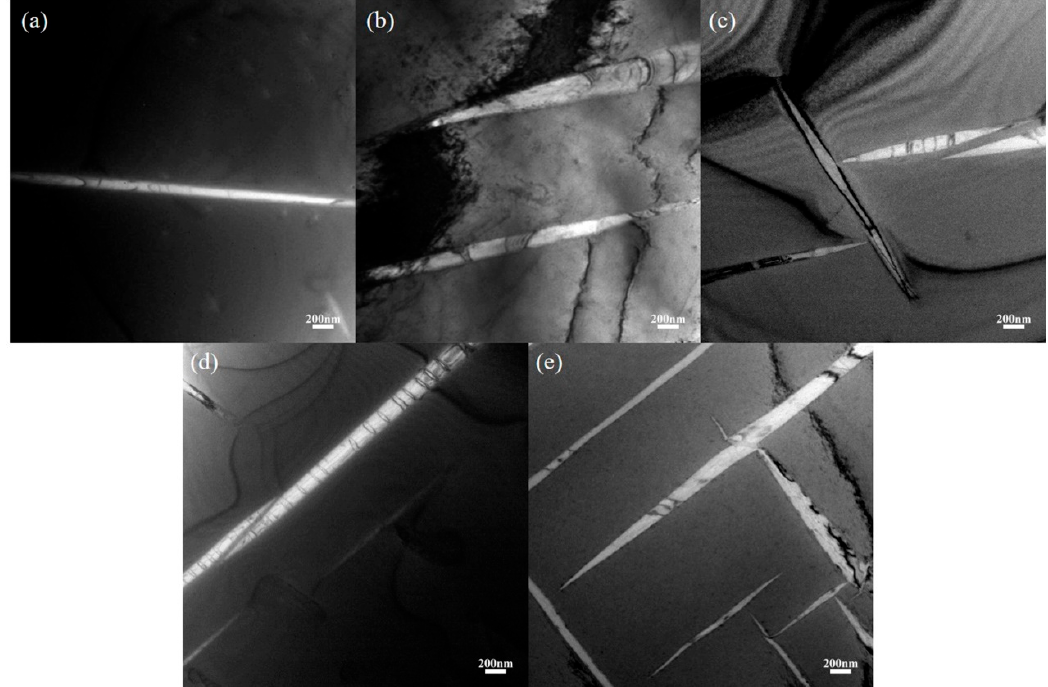
Figure 1. XRD patterns of the Zr-16Nb-xTi alloys.